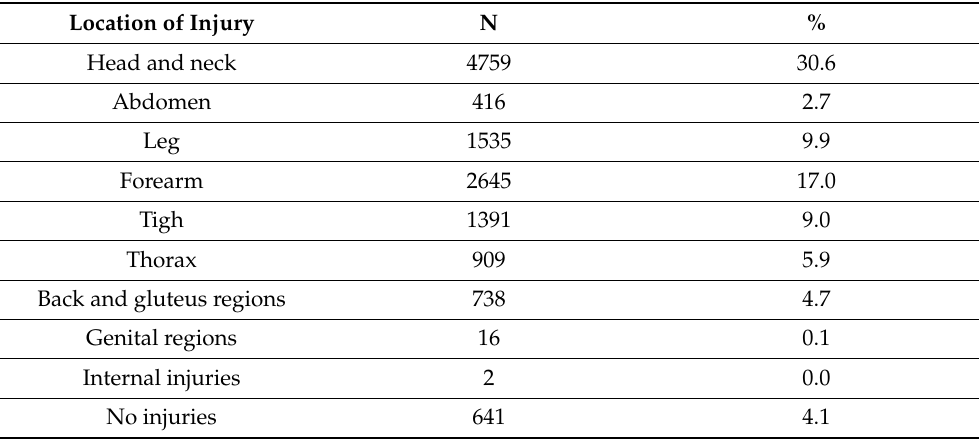
Table 8. Locations of Injury ( n =